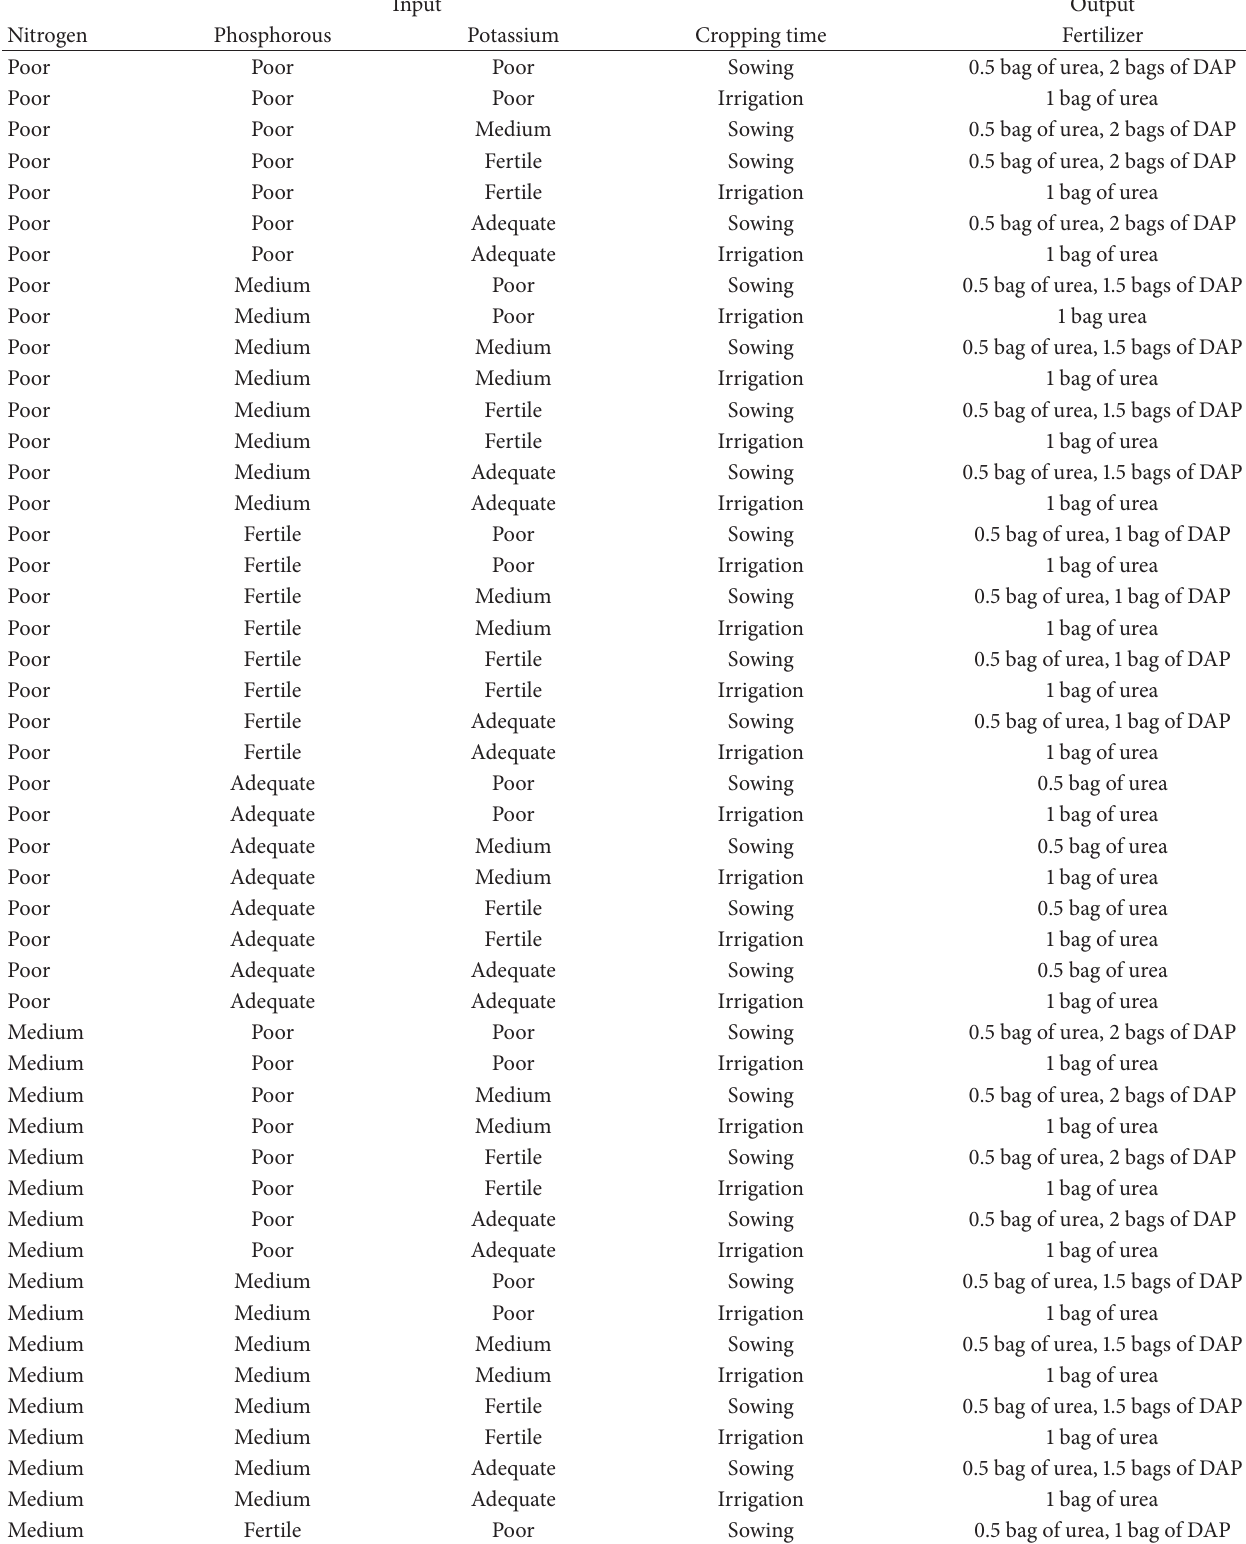
Table 3: Fuzzy rules for irrigated